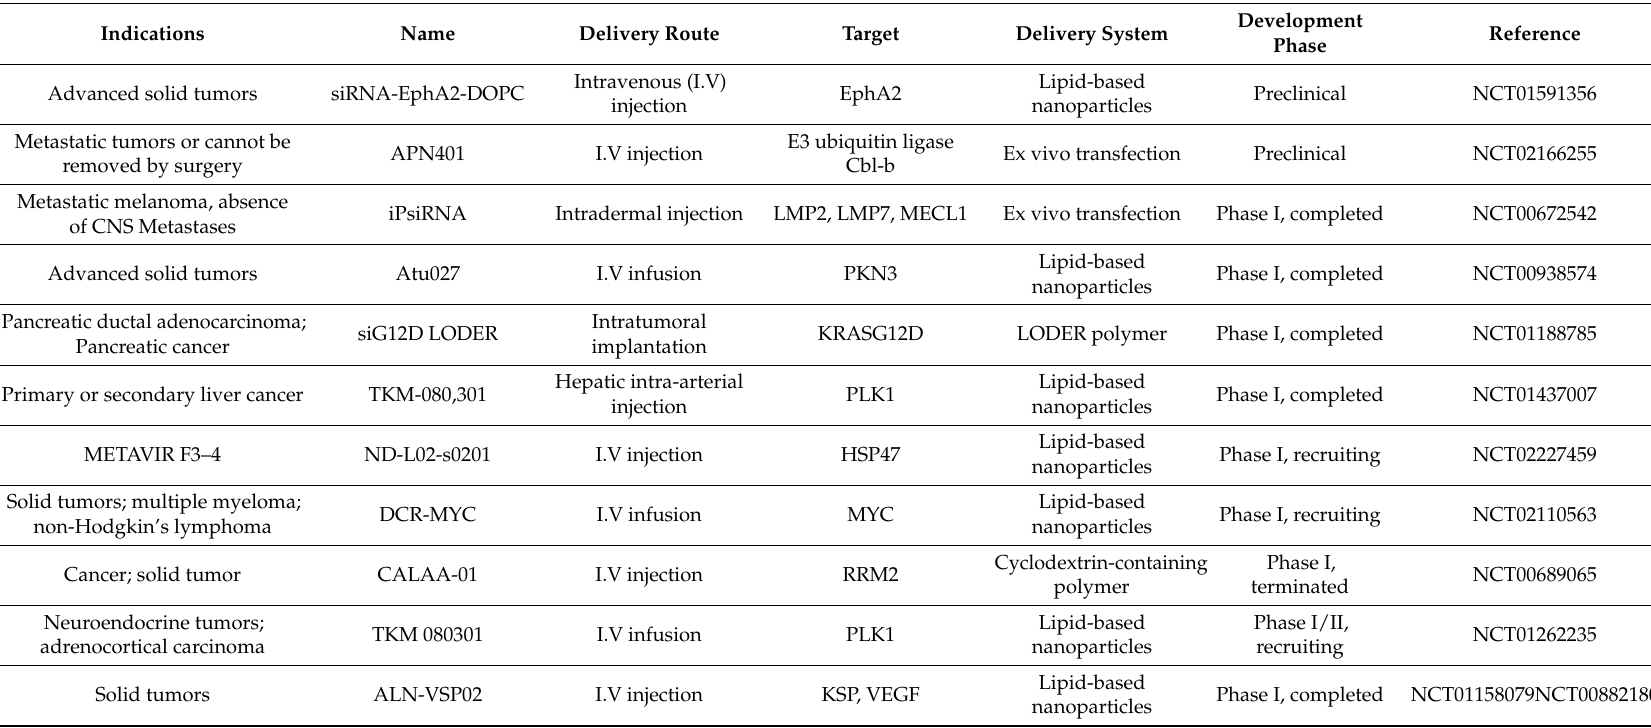
Table 1. Current clinical status of RNAi therapeutics for cancer treatment (Taken with permission from [15]. Copyright Elsevier,